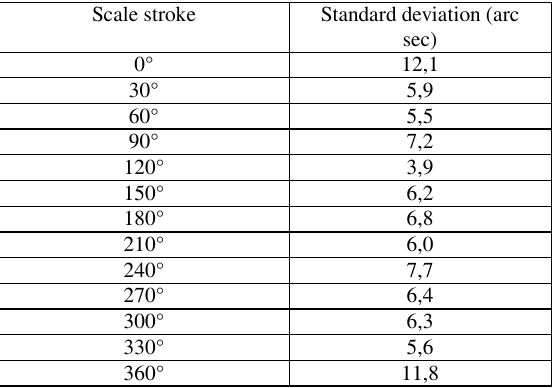
Table 1. Values of standard deviation (autocollimator and microscope readouts)